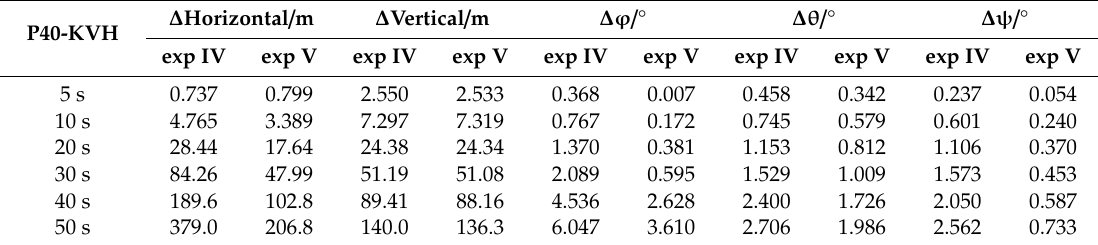
Table 3. The di ff erence values of the horizontal and vertical position, roll, pitch and yaw between GNSS / IMU-P40 (our program in a 15-state Kalman filter) and GNSS / KVH coupled navigation (IE software), at di ff erent epochs of the seconds of GNSS blocked in experiments IV and V. ∆ Horizontal / m P40-KVH